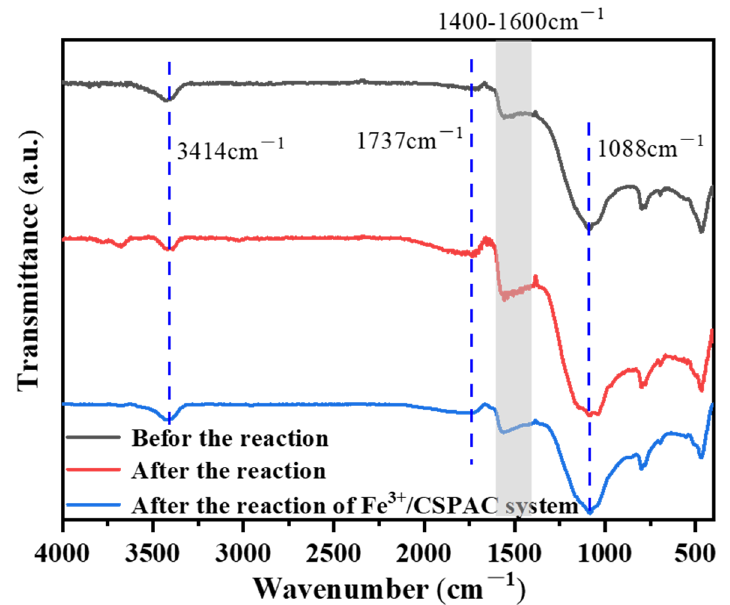
Figure 10. FT-IR spectra of CSPAC before and after the reaction in the Fe 3+ /H 2 O 2 /CSPAC system, and after reaction in the Fe 3+ /CSPAC system.